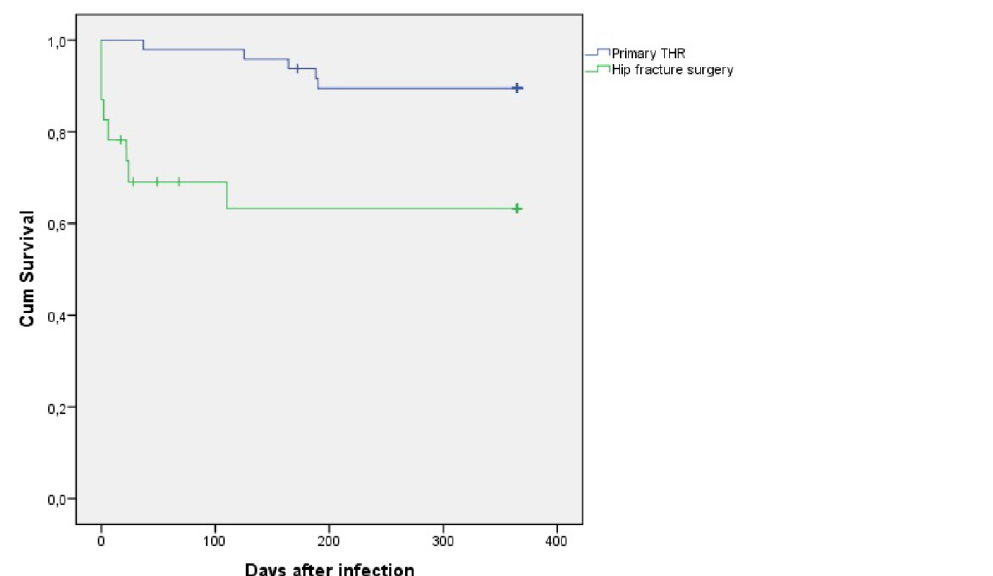
Figure 1. Percentage micro-organisms associated with PJI in primary THR and after hip fracture surgery